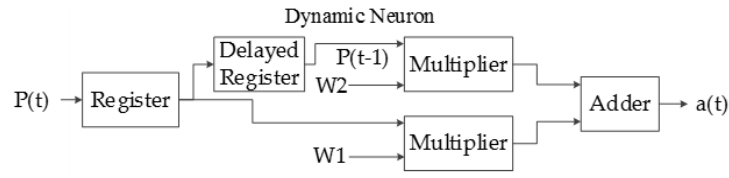
Figure 18. Dynamic neuron hardware.